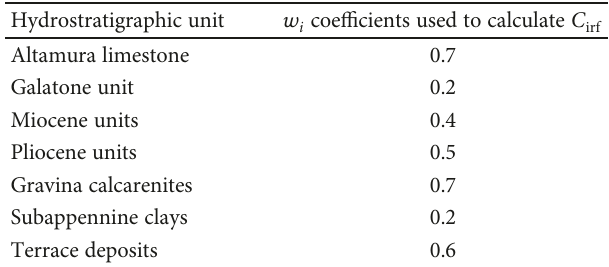
ffi cients used to calculate C Table 2: w i coe Filippis et al.